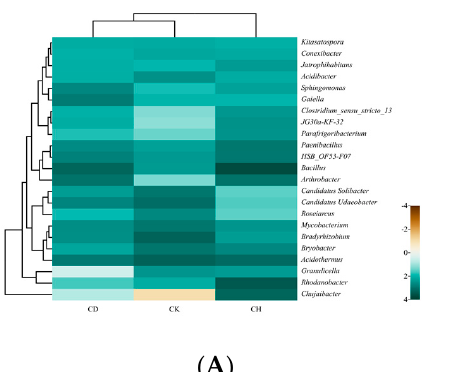
Figure 5. Bacterial and fungal compositions and community structures in the three soil samples. ( A ) Bar plot of the bacterial community at the phylum level. ( B ) Bar plot of the fungal community at the phylum level. The relative abundance in each sample was calculated on the basis of the percentage of the total effective sequences, which were classified using the RDP classifier and compared with